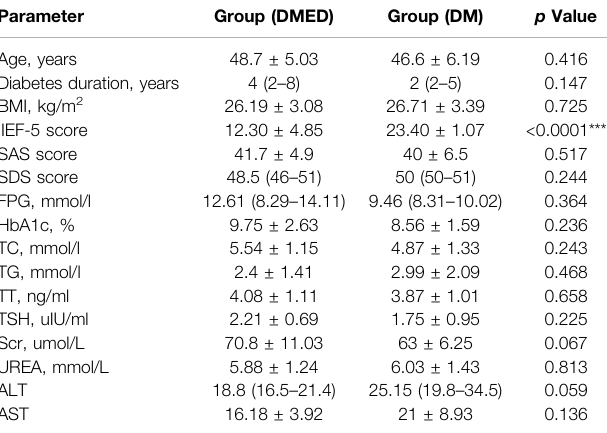
TABLE 1 | Comparisons of clinical data. BMI, body mass index; IIEF-5, international index of erectile function 5; SAS, self-rating anxiety scale;